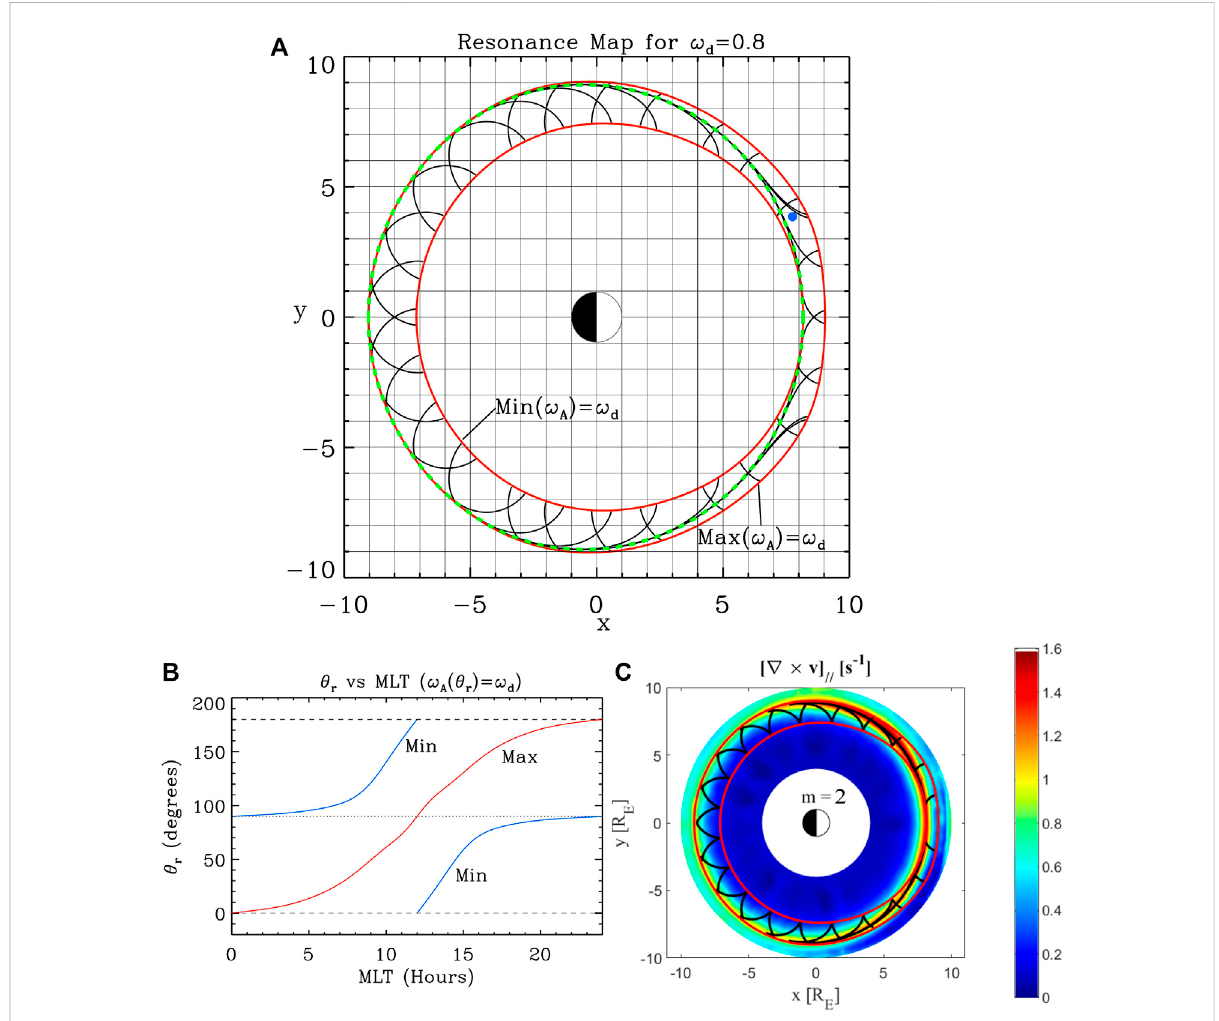
FIGURE 10 SummaryofResonantZoneinvestigationsinacompresseddipolecon fi guration(TakenfromWrightetal.(2022),Figures3A,BandFigure4): (A) Calculation of Resonant Zone boundaries (solid red curves) and resonant paths (black curves) using the method of Wright and Elsden (2016). The green dashed line indicates the predicted peak location of a low m FLR; (B) Red (Blue) curves show the variation with MLT of equatorial polarization for the boundaries of the Resonant Zone corresponding to Max ( ω A ) = ω d (Min ( ω A ) = ω d ); (C) Equatorial map of the parallel vorticity amplitude, |( ∇ × v ) (cid:4) |, (associated with SAWs) produced by the coupled MHD wave model of Degeling et al. (2018), for an externally driven 0.8 mHz wave source with m = 2 at the outer boundary. Solid black and red lines respectively indicate Resonance Map trajectories and Resonant Zone boundaries (using the same calculation method as plot (A)